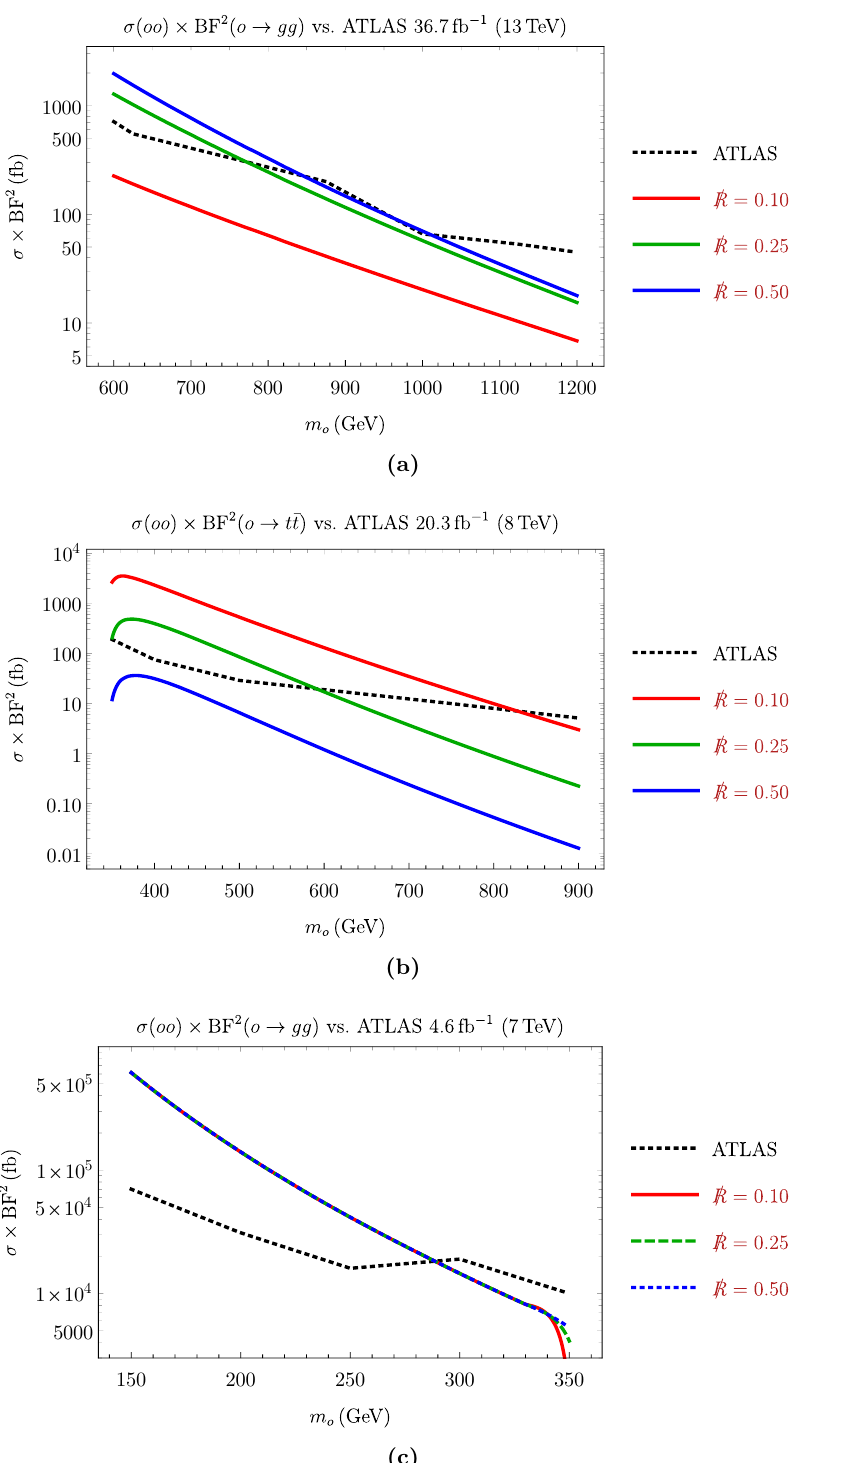
Figure 14. Cross sections in Benchmarks 1–3 of pseudoscalar sgluon pair production, with sub- sequent decays to gluons or top-antitop pairs, compared to exclusion bounds from three ATLAS searches for color-octet